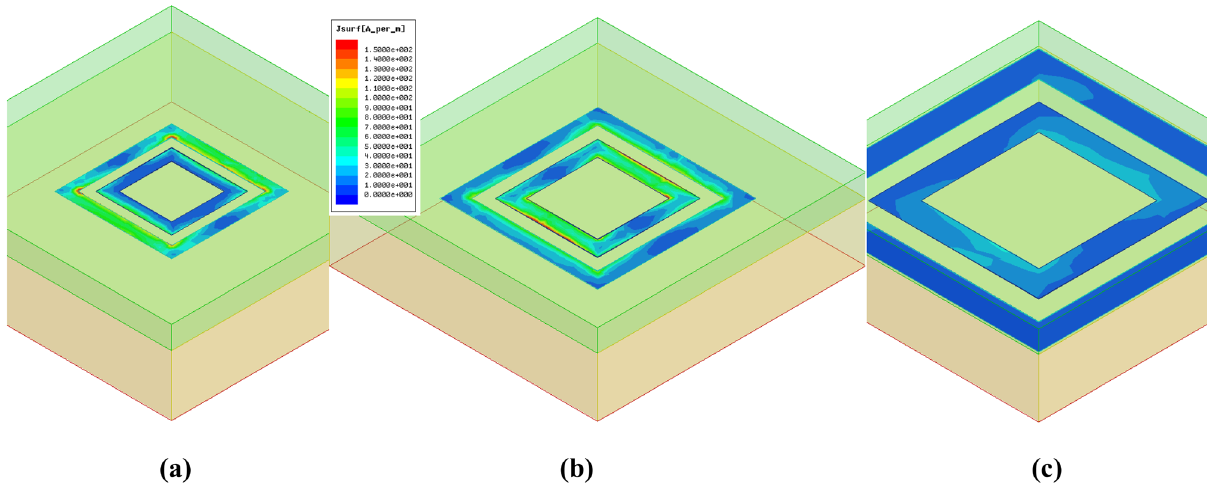
Figure 4. Current distributions on the proposed element at frequency f = 8.2 GHz: (a) L 1 = 7.75 mm; (b) L 1 = 10.75 mm; (c) L 1 = 18